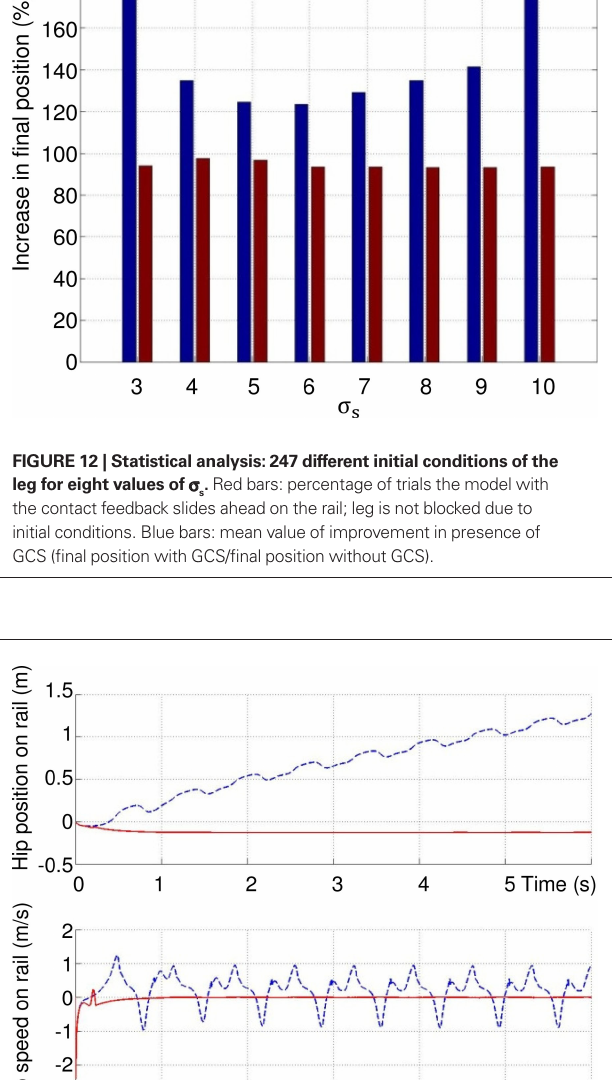
FiguRe 14 | influence of σ top σ = 3, bottom σ s